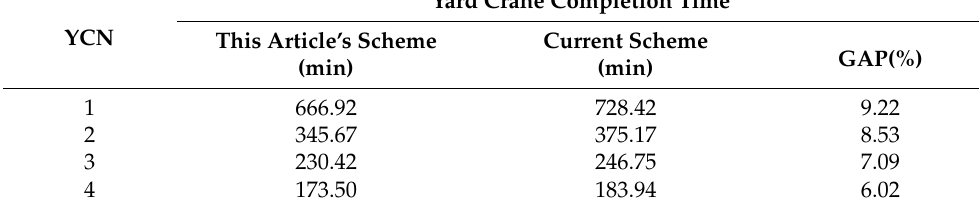
Table 7. Comparison of